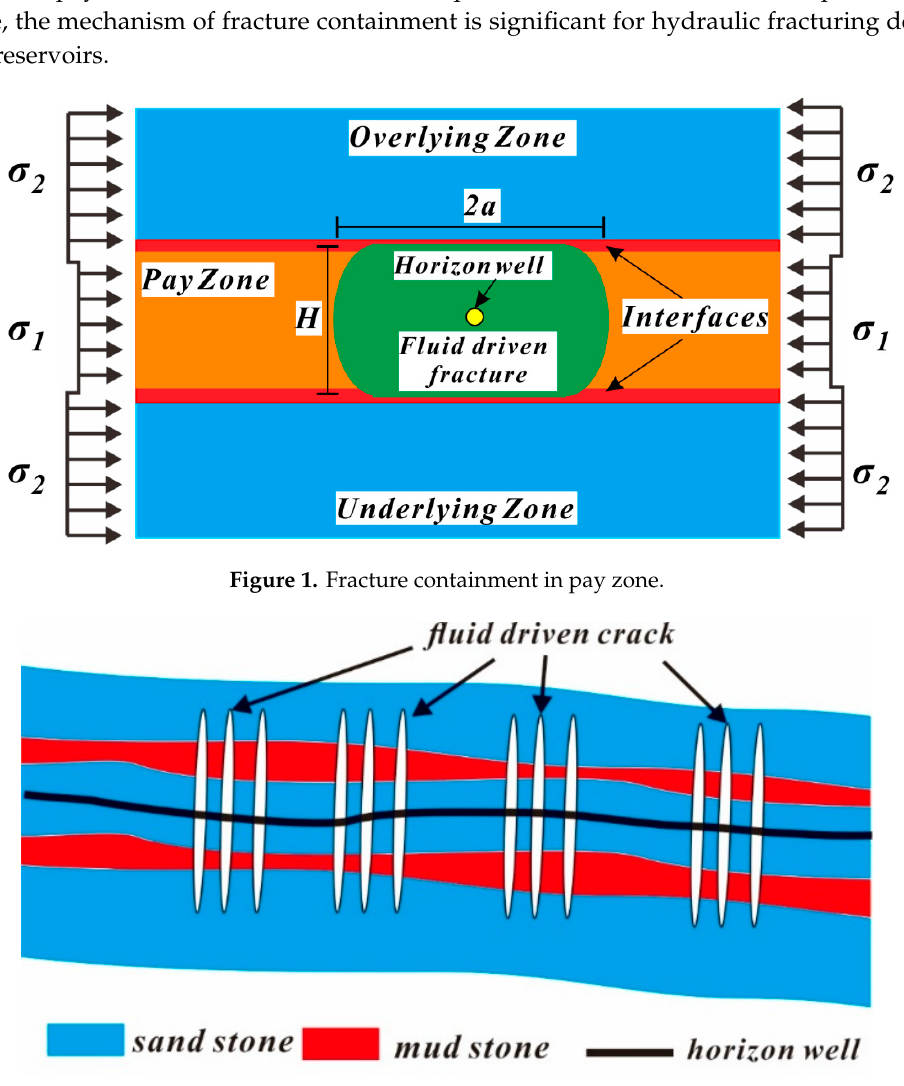
Figure 2. Translayer fracturing in interbed of sandstone and mudstone.